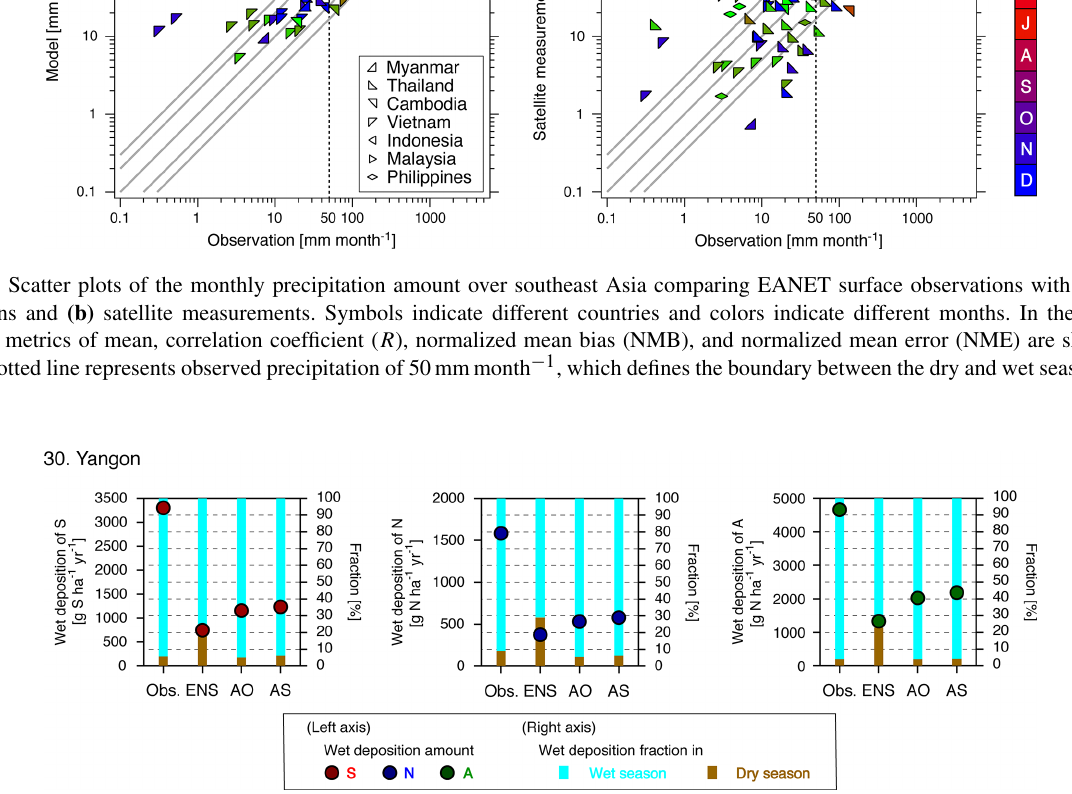
Figure 10. Observed and simulated annual accumulated wet deposition amounts of S, N, and A, and the fraction of wet deposition during the wet and dry seasons in Yangon,